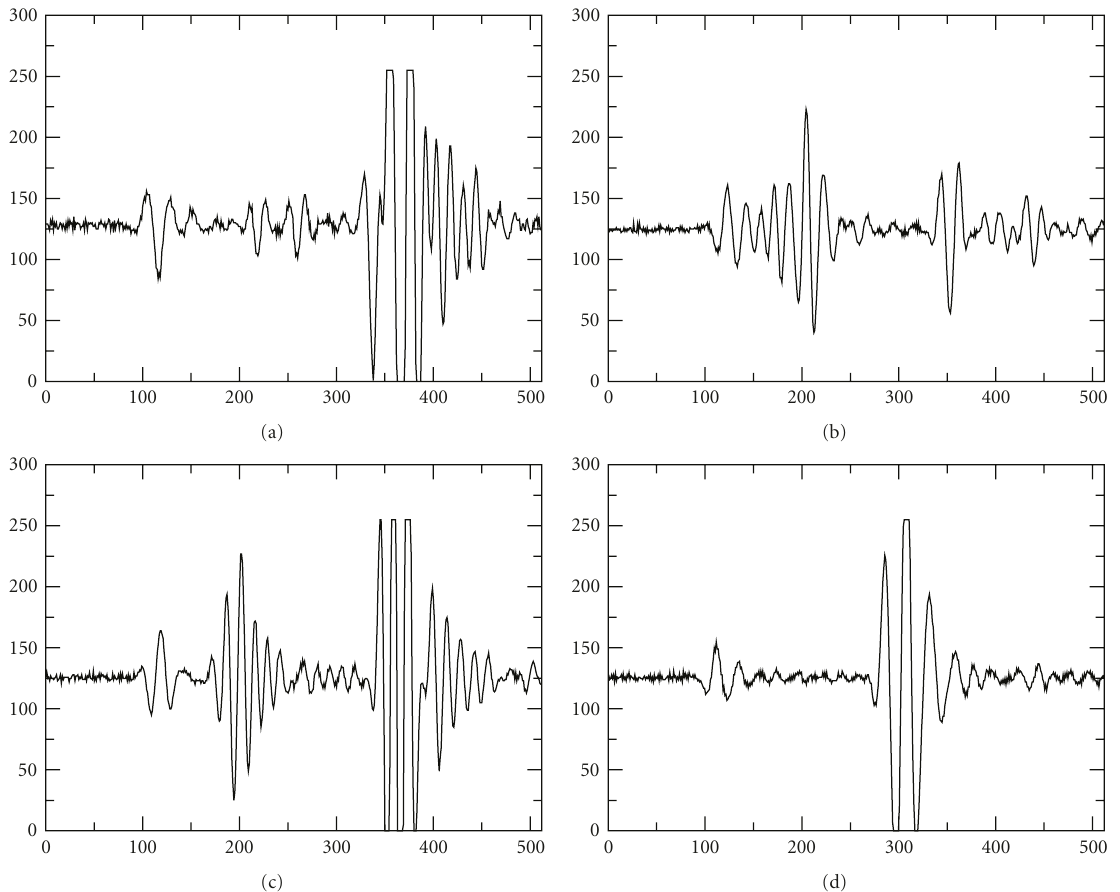
Figure 2: Typical examples of signals obtained from samples with (a) lack-of-fusion defects, (b) lack-of-penetration defects, (c) porosities, and (d) no defects. The horizontal axes correspond to the time direction, in units of the inverse sample rate of the equipment.